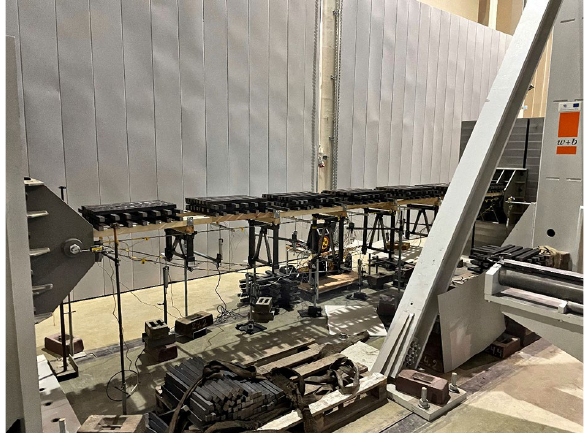
Figure 8. Photo of the experimental model and the load during the